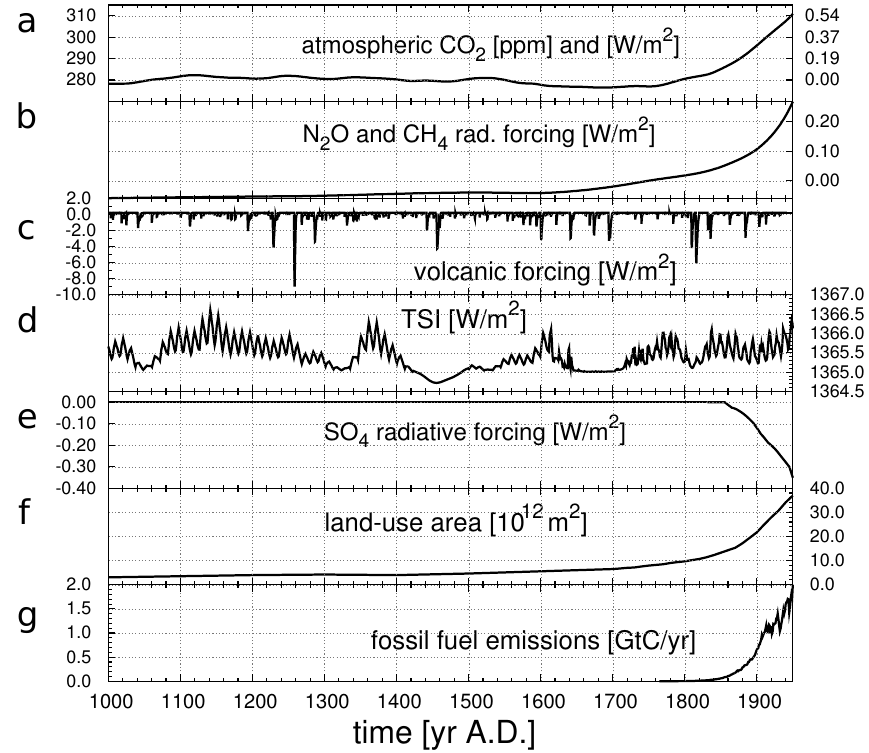
Fig. 4. Forcings for the last millennium including the industrial period: (a) atmospheric CO 2 used both for the radiative forcing as well as for the biogeochemical code, (b) radiative forcing of CH 4 and N 2 O reported as deviation from preindustrial values, (c) volcanic forcing, (d) solar forcing, (e) SO 4 radiative forcing, (f) anthropogenic land-use area and (g) carbon emissions from fossil fuel use (including cement production). The reader is referred to the main text for details and references to the individual forcing